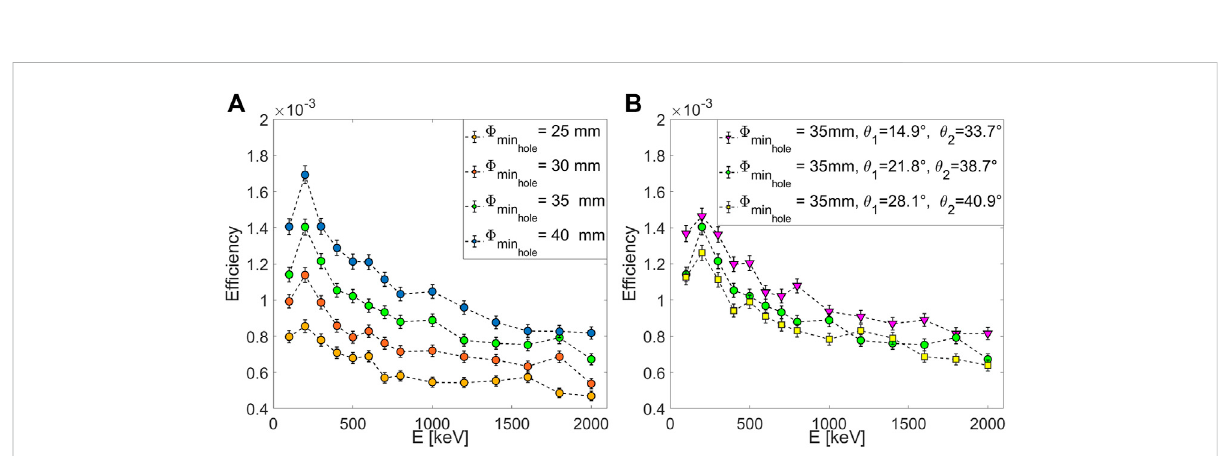
FIGURE 9 (A) Ef fi ciency plots as a function of the incident γ -ray energy for HPGe detectors. An ellipsoidal source was used. The colors of the symbols correspond to simulations performed using different hole sizes for collimators. (B) Same as A but in this case the effect of different angles of inclination of the conical holes was